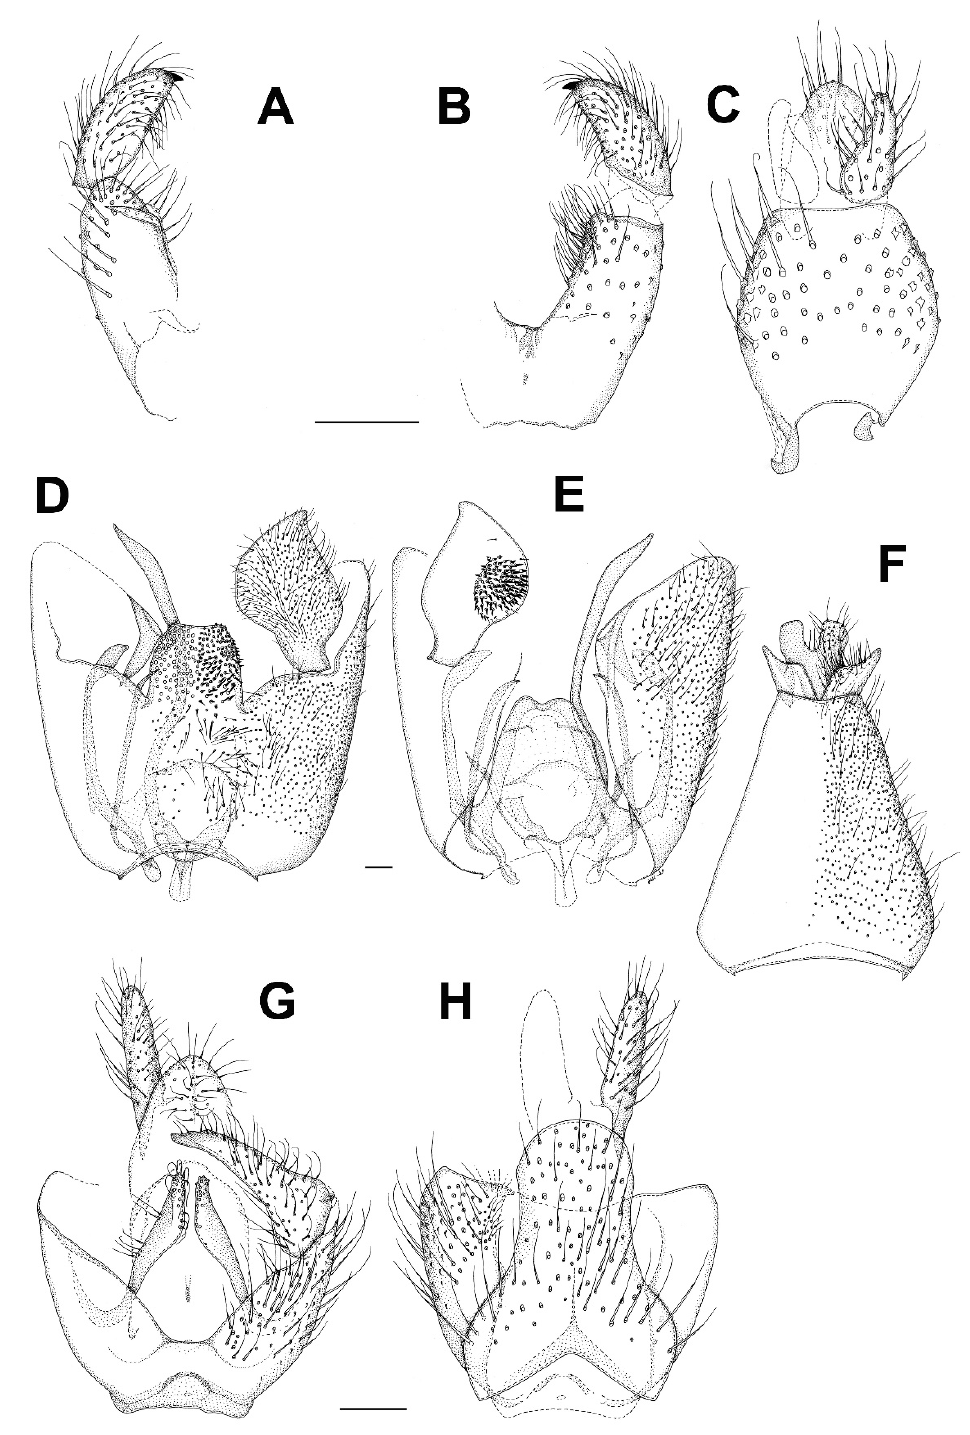
Figure 13. Male terminalia of new species of Keroplatidae. Chetoneura davidi sp. nov. (holotype), ( A ) dorsal view,( B ) ventral view, ( C ) tergite 9; Euceroplatus mantici sp. nov. (holotype), ( D ) ventral view, ( E ) dorsal view, ( F ) tergite 9; Platyceridion yunfui sp. nov. (holotype), ( G ) ventral view, ( H ) dorsal view. Scale bars: 0.1 mm.